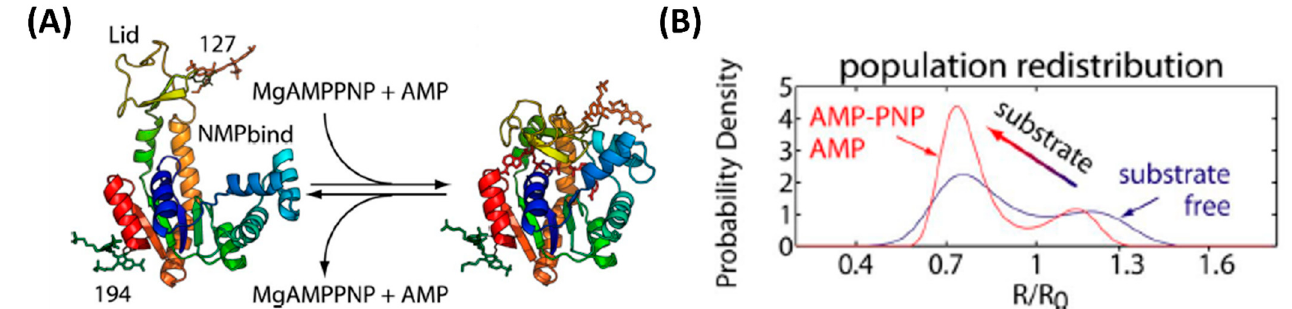
Figure 3. ( A ) Open and closed conformation of AK. The donor and acceptor dyes are labeled at A127 and A194 residues. The open (left) and closed (right) conformations represent the substrate-free and substrate-bound states of AK, respectively. ( B ) The change in R/R 0 reflects the relative change in distance between the donor and acceptor. The population of molecules with a smaller distance (representative of closed conformation) increases significantly upon substrate binding. Figure is adapted from [27] (Hanson, J.A.; Duderstadt, K.; Watkins, L.P.; Bhattacharyya, S.; Brokaw, J.; Chu, J.W.; Yang, H. Illuminating the mechanistic roles of enzyme conformational dynamics. Proc Natl